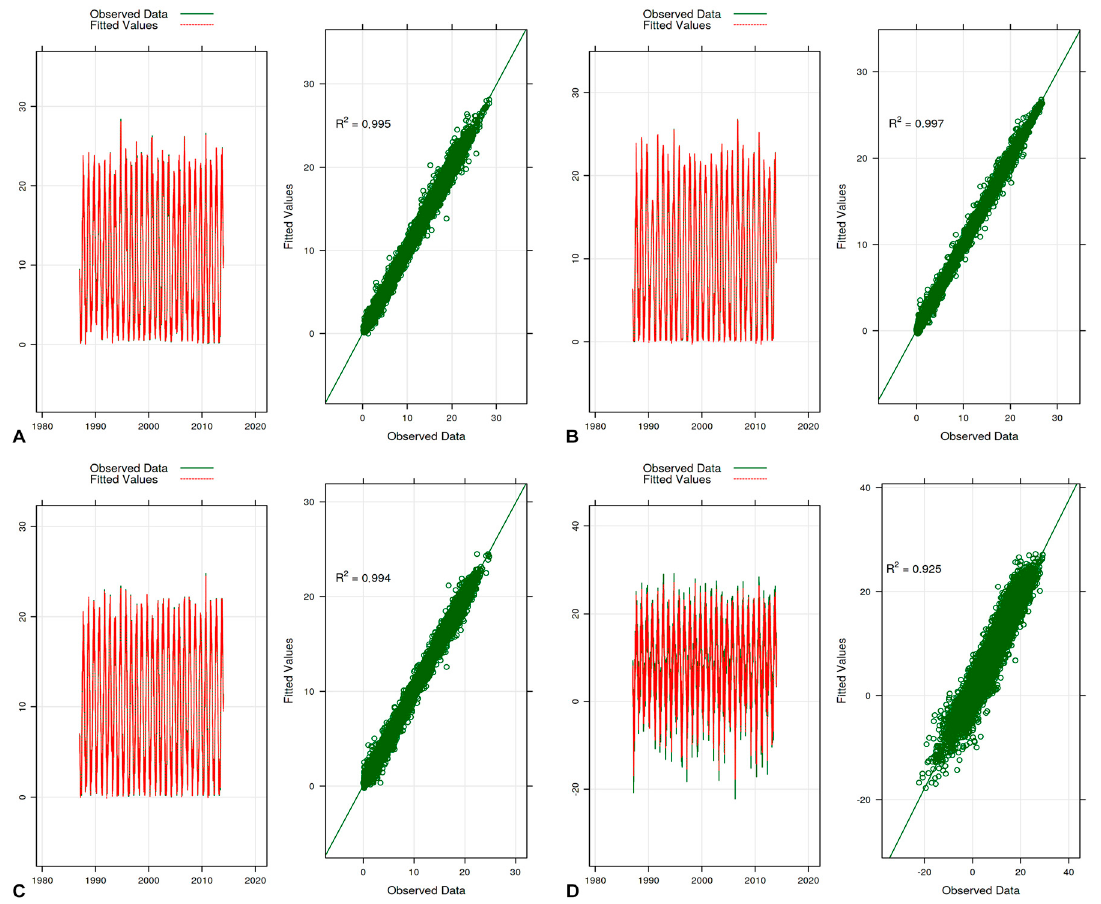
Figure 8. Prognostic models of river water and air temperatures elaborated on the basis of the ARIMA model: ( A ) Note ć -Pako ść , ( B ) Note ć -Uj ś cie, ( C ) Note ć -Nowe Drezdenko, ( D ) Pi ł a-air temperature.